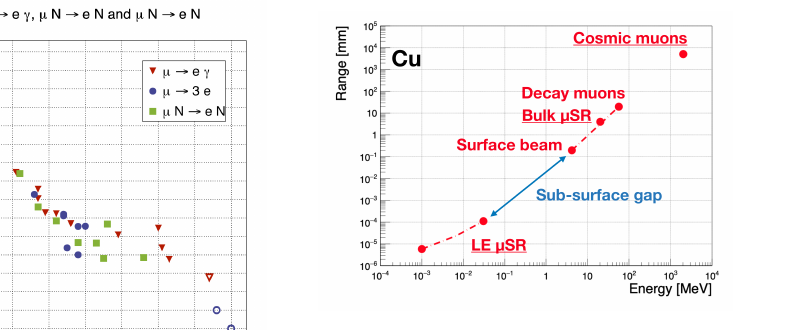
Figure 2. Calculated muon stopping ranges in Copper (Cu) as a function of the incom- ing muon energy. Plot modified from [9]. Typically used muon energies for µ SR mea- surements restrict the probed ranges to either < 200nm (low-energy muons, LE- µ + ) or ≥ 100 µ m (surface- and decay-muon